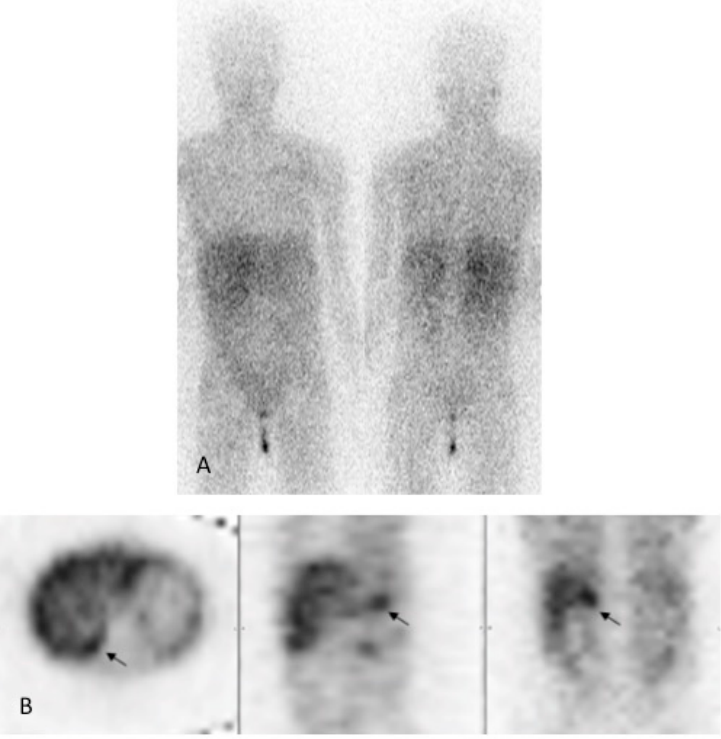
Figure 4. [ 123 I]-mIBG scintigraphy. ( A ) Anterior (left) and posterior (right) planar images show physiological uptake in the salivary glands and liver and urinary activity. ( B ) Axial, sagittal and coronal SPECT images demonstrate focal uptake (black arrow) above the superior pole of the right kidney corresponding to the adrenal lesion.